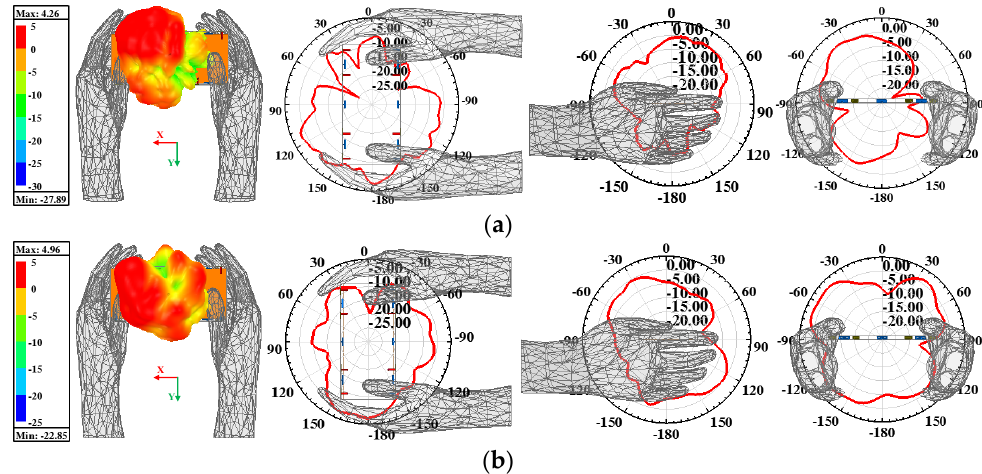
Figure 7. Simulated 3D and 2D patterns when ( a ) Ant. 8 excited at 3.5 GHz and ( b ) Ant. 7 excited at 4.9 GHz.